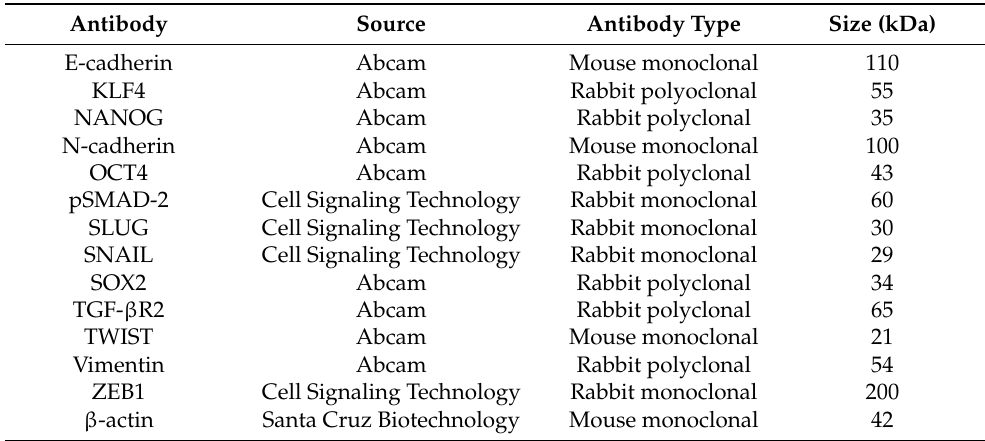
Table 2. Antibodies used for western